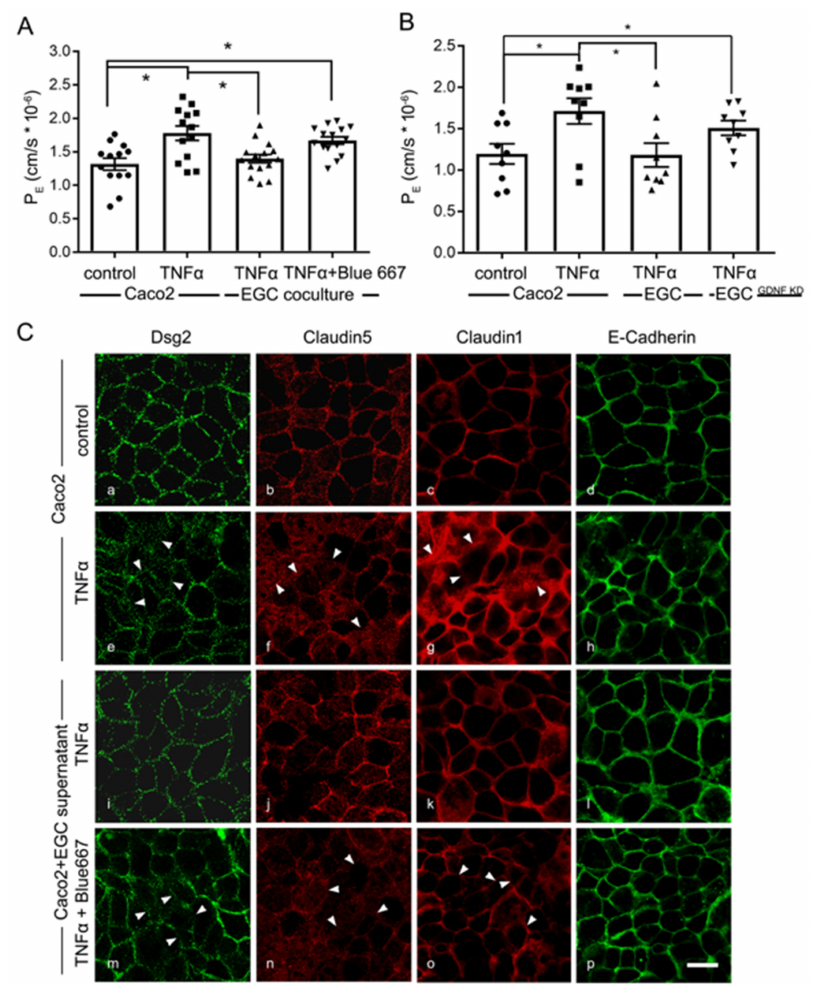
Figure 8. Barrier protective effects by enteric glial cells (EGC) in inflammation are glial cell line-derived neurotrophic factor (GDNF)-dependent. ( A ). Permeability coefficients (P E ) of 4-kDa FITC dextran flux across Caco2 monolayers was increased following the application of Tumor necrosis factor α (TNF α ) to 1.78 ± 0.10 × 10 − 6 compared to 1.32 ± 0.08 × 10 − 6 . This was blocked under co-culture conditions together with EGC cells. Protective effects of the co-culture were diminished by Blue667 when P E was 1.67 ± 0.06 × 10 − 6 ( n = 9; * = p < 0.05; One-way ANOVA). Control = Caco2 monolayer without treatment. ( B ). In P E measurements barrier protection of EGCs after TNF α incubation were absent when co-cultures were performed with EGC GDNF KD ( n = 9; * = p < 0.05; One-way ANOVA). ( C ). Representative immunostaining for junctional proteins Dsg2, E-Cadherin, Claudin1 and 5 are shown. TNF α reduced the staining pattern of these junctional proteins at the cell borders of Caco2 cells. This effect was attenuated when Caco2 cells were cultivated with EGC supernatants. The beneficial effects of EGC supernatants were blocked by RET Inhibitor Blue667; arrowheads point to examples of reduced or lost staining patterns at the cell borders (representatives are shown for n = 6, Scale 20 µ m); Control = Caco2 monolayer without